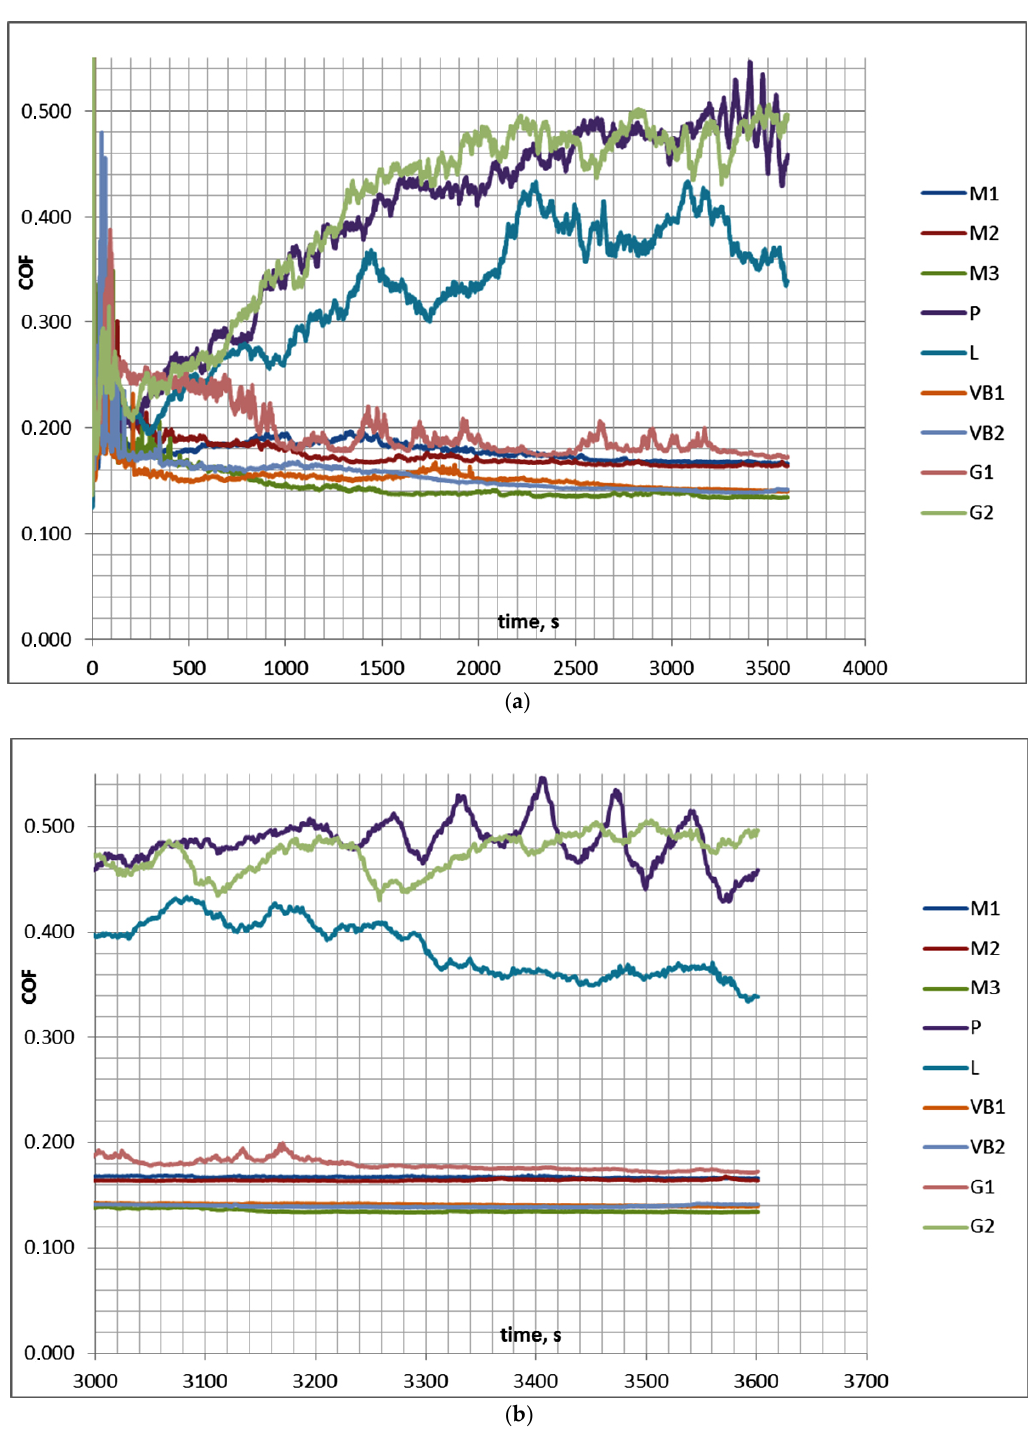
Figure 6. Friction coefficients for the whole test B1 ( a ) and for its last 10 min ( b ).